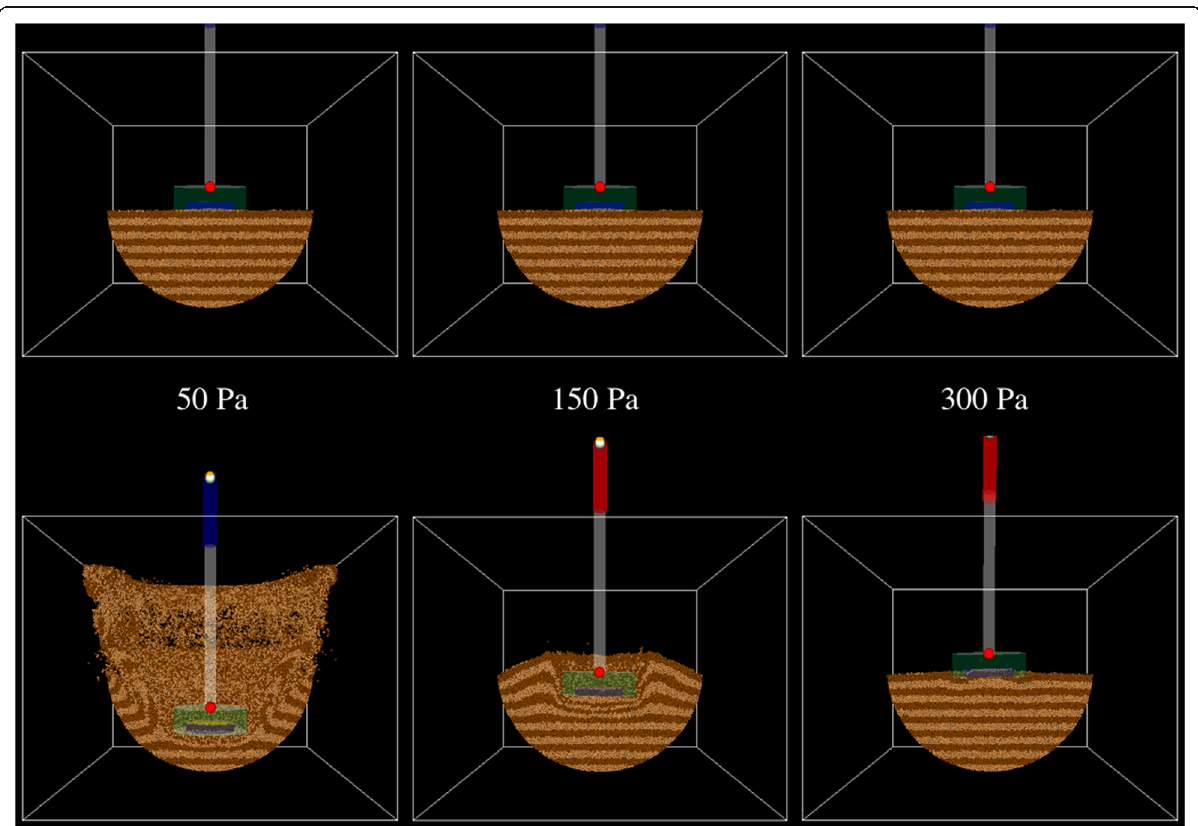
Fig. 1 Effect of regolith cohesive strength on simulated sampling encounters, modeled on the OSIRIS-REx mission. Weak regolith only offers weak resistance to the slow speed impact, while stronger regolith effectively stops penetration at the surface. The top figures show the configuration at impact, while the bottom figures show the maximum penetration. Simulation details and models are defined and discussed in Bierhaus et al.